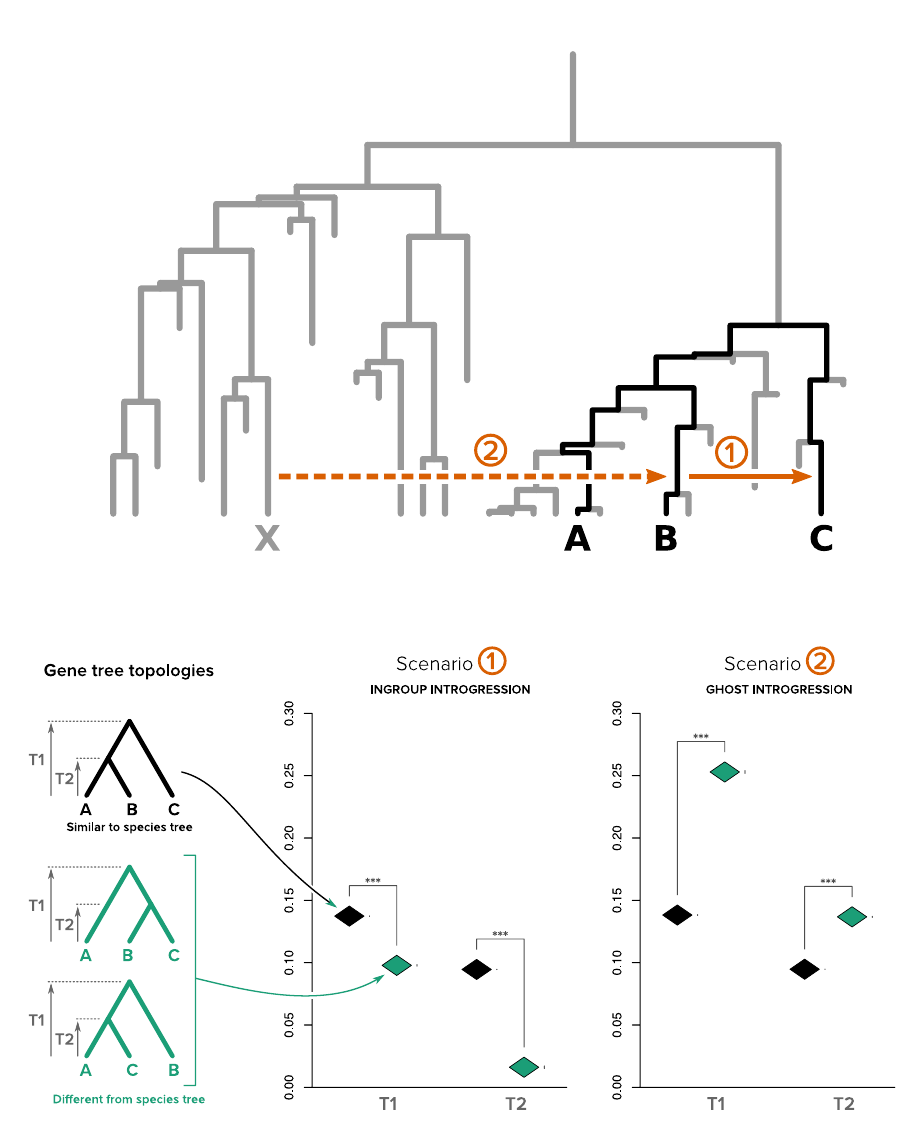
Fig 4. Impact of ghost lineages on the use of branch lengths to choose between alternative species trees. Top panel: the complete species tree, black branches represent the ABC tree while gray branches represent ghost lineages. Genome evolution (1,000 genes) was simulated under 2 different introgressions scenarios: scenario 1, ingroup introgression (solid orange arrow) between species B and C, and scenario 2, ghost introgression (dotted orange arrow) between ghost lineage X and species B. Bottom panel. Left: the 3 possible topologies representing the relationship between species A, B, and C. Right: The mean divergence times T1 and T2 were computed for both scenarios and for all genes supporting either the species tree topology ((A,B),C) (black rhombus) or the 2 discordant topologies ((B,C),A) and ((A,C),B) (green rhombus; whiskers standard error of the mean, ��� for t test with P -value < 2.2 × 10 − 16 ). Data underlying this figure can be found on Zenodo (doi: 10.5281/zenodo.6901799) and GitHub (https://github.com/